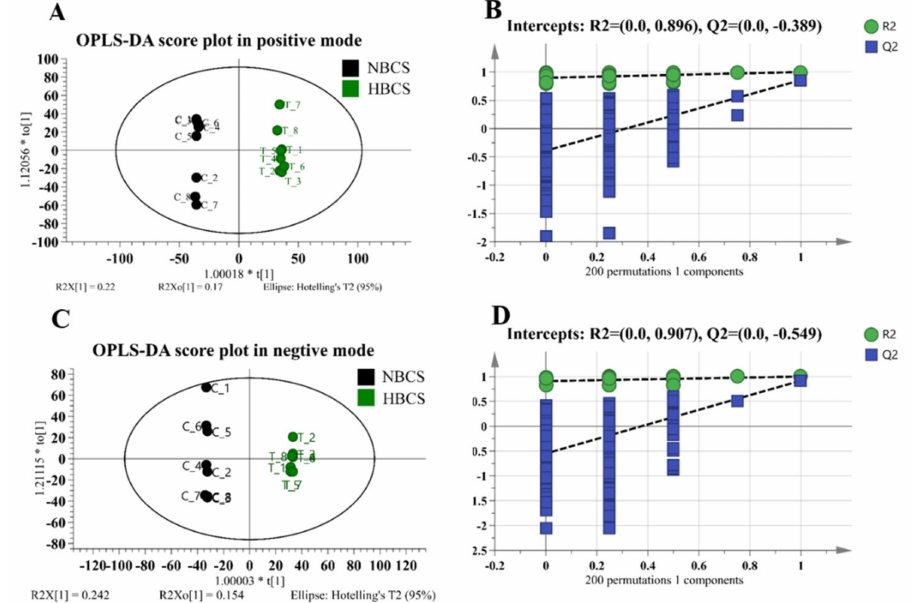
Figure 1. ( A , C ) Orthogonal partial least squares discriminant analysis (OPLS-DA) plot of plasma of cows with di ff erent calving body condition score in the positive and negative ion mode, respectively. ( B , D ) permutation test plots of plasma of cows with di ff erent calving body condition score in the positive and negative ion mode, respectively.